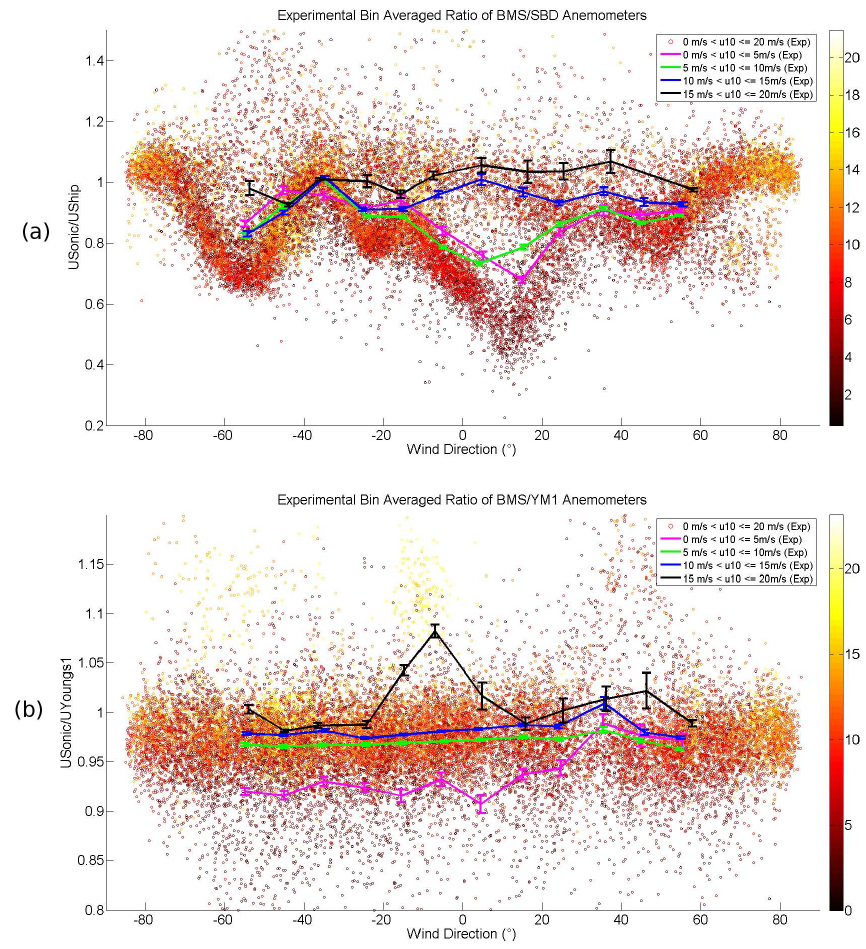
Fig. 5. (a) Experimental bin-averaged wind speed line plots between the BMS and the SBD anemometers over a range of direction from − 60 to + 60 ◦ , also with experimental scatter plot of full wind speed range and standard deviation error bars. (b) Experimental bin-averaged wind speed line plots between the BMS and the YM1 anemometers over a range of direction from − 60 to + 60 ◦ , also with experimental scatter plot of full wind speed range and standard deviation error